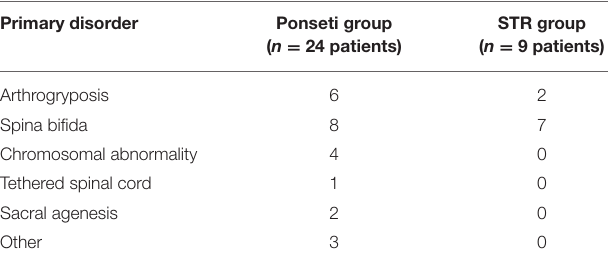
TABLE 1 | Etiology of non-idiopathic clubfoot.